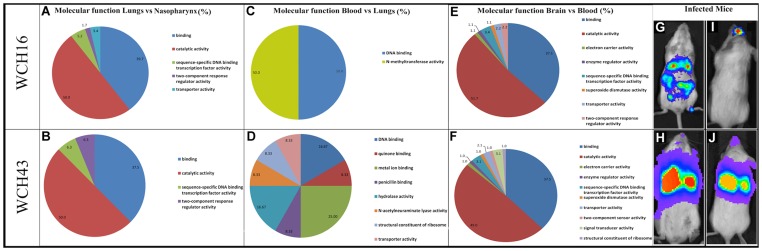
Functional genomics catalogues of S. pneumoniae WCH16 and WCH43 pathogenesis in different host tissues.(A and B), Lungs versus Nasopharynx; (C and D), Blood versus Lungs; (E and F), Brain versus Blood. (G–J): Bioluminescent imaging of WCH16- or WCH43- infected mice at 72 h post-challenge, showing bacteria in the nasopharynx, lungs, blood and brain. G and H; ventral views, I and J; dorsal views of infected mice.